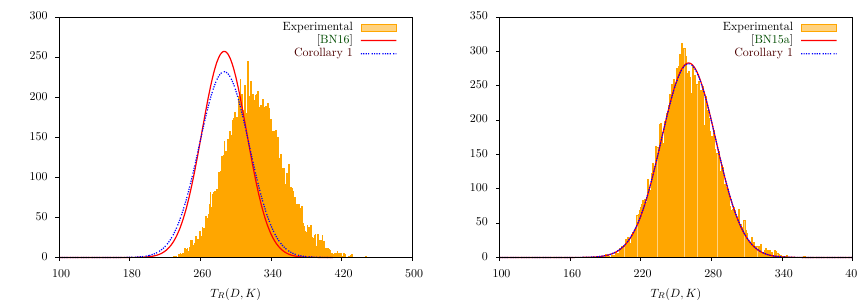
Figure 8: Comparison between the experimental distribution of T R ( D, K ) and normal distributions with different variances. Both figures are for 2 15 plaintexts. Left: over 6 rounds. Right: over 7